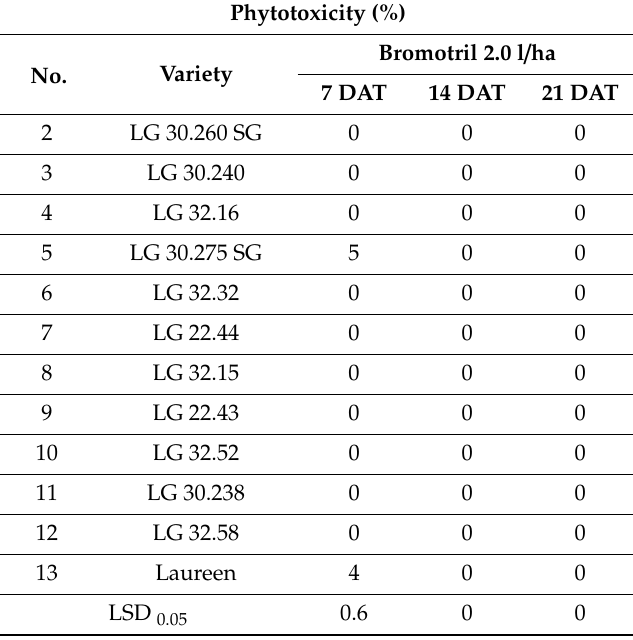
Table 5. Sensitivity of maize varieties to the herbicide Bromotril 250 SC (bromoxynil) .